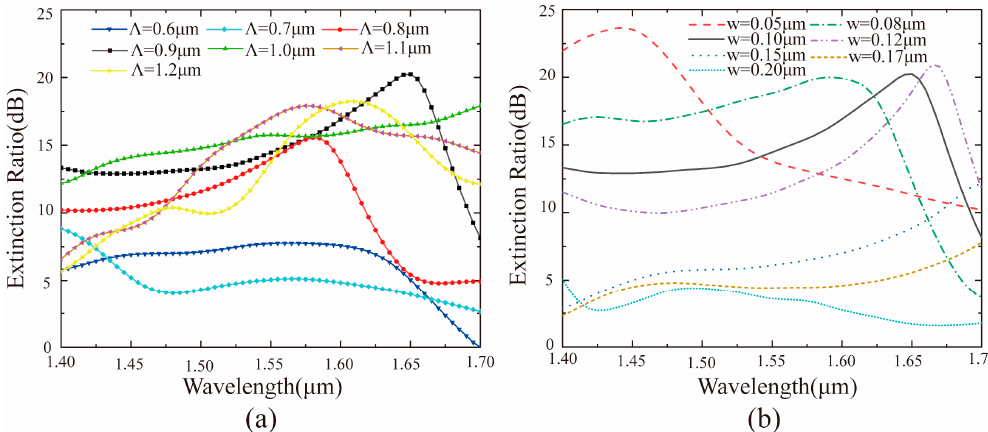
Figure 3. The relationship between the extinction ratio of the directional coupler and the corresponding wavelength, when changing the geometric parameters of the catenary structure. ( a ) Shifting the horizontal length Λ of the catenary. ( b ) Shifting the width w of catenary structure.